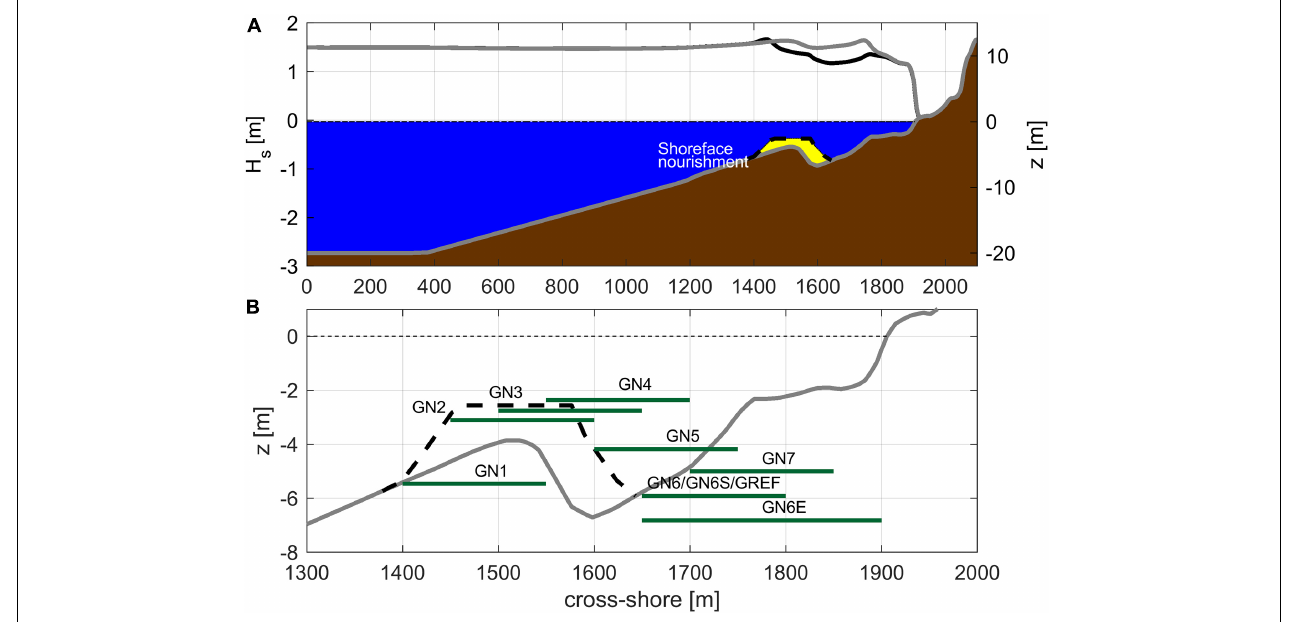
FIGURE 2 | Geometry showing: (A) nourishment on top of a nearshore sand bar and the significant wave height profile under mild wave condition ( H m = 1.5 m, T = 8 s), with gray line for wave height for the reference (REF) and black line for wave height for the nourishment reference (SN); (B) location and length of seagrass